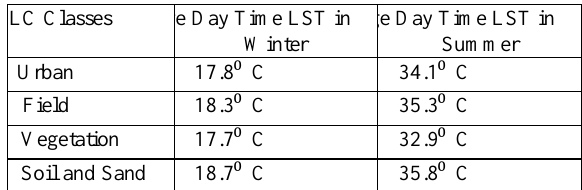
Table 1. Average LST of major LULC classes